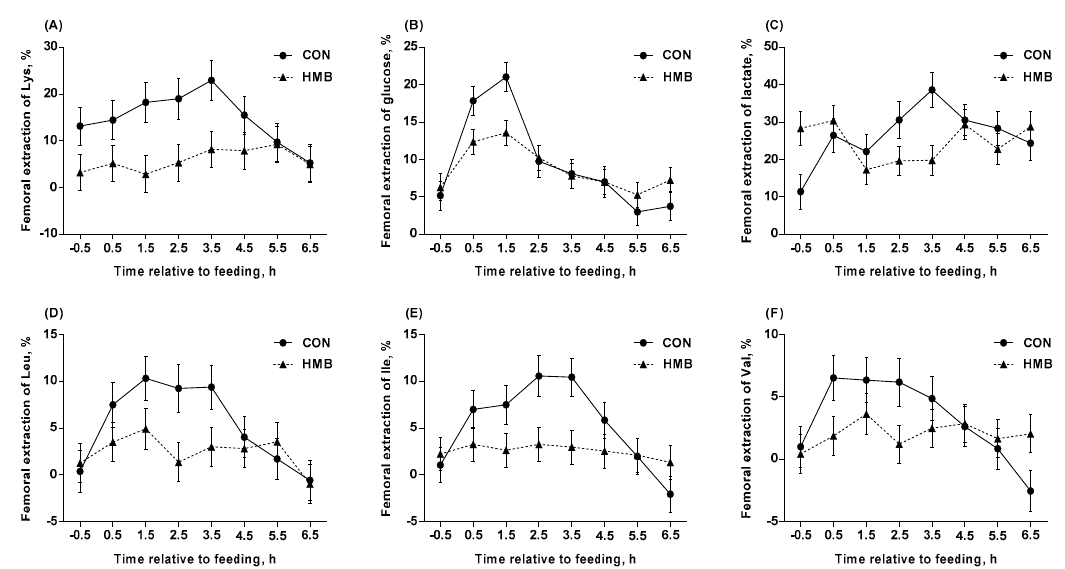
Figure 4. Femoral extractions of Lys ( A ), glucose ( B ), lactate ( C ), Leu ( D ), Ile ( E ), and Val ( F ) in control (CON) and HMB-supplemented (HMB) sows during late gestation. Data are expressed as the mean ± SEM. Sows were regarded as the experimental units, n = 4 for each group. Interactions of treatment (CON, HMB) and sampling time after feeding were observed for femoral extractions of Lys ( p = 0.001), glucose ( p = 0.004), lactate ( p = 0.006), Leu ( p = 0.10), Ile ( p = 0.01), and Val ( p = 0.04), respectively. CON = control; HMB = β -hydroxy- β -methyl butyrate.